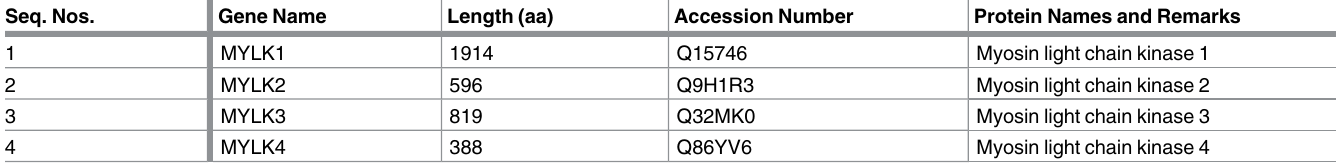
Table 6. Details of MLCK protein family membersin human. Seq.